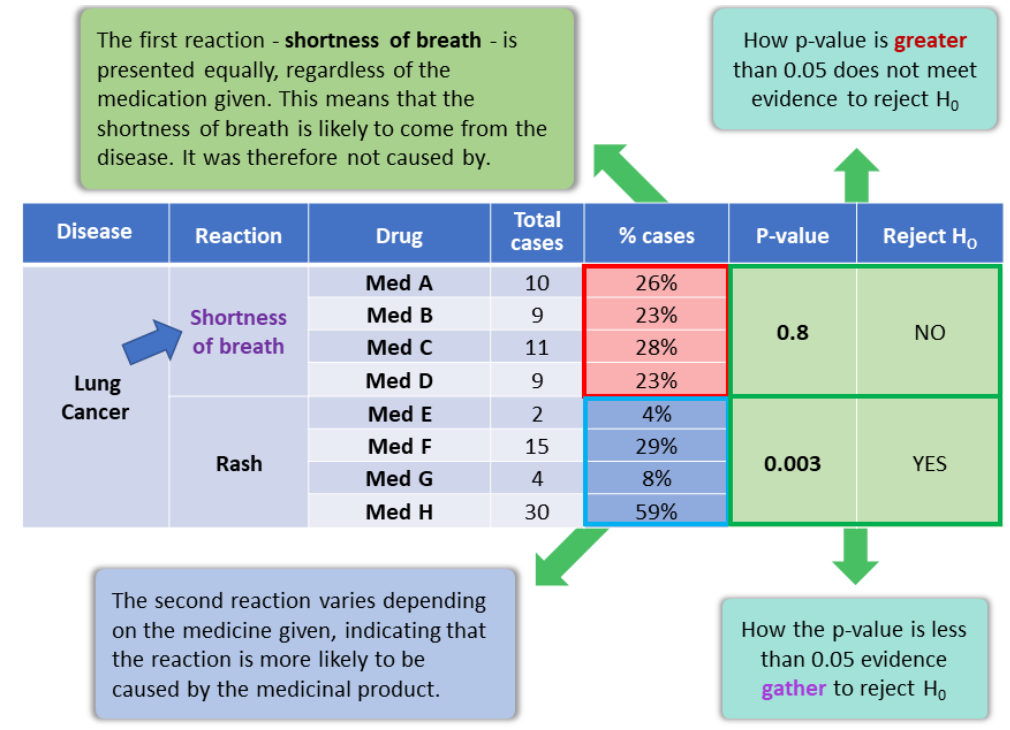
Figure 4. Pearson’s Test simulation for correlation